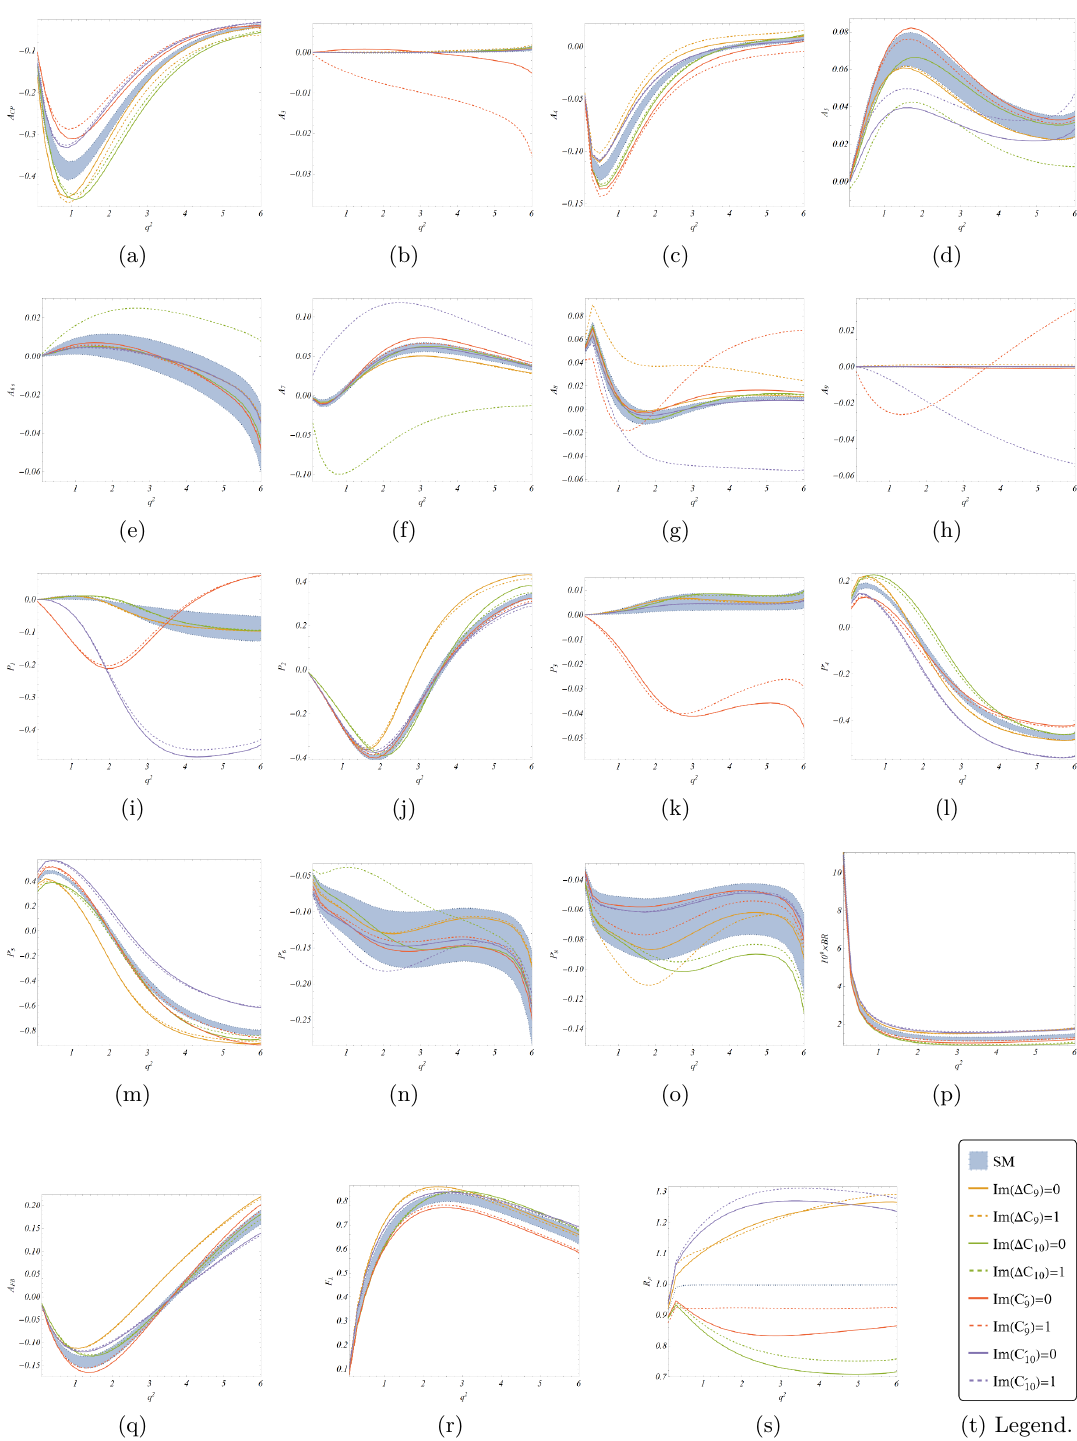
Figure 2 . The q 2 dependence of the observables in B ± → ρ ± ll decays, which are measurable at both the LHCb and Belle. The variations are shown in the SM and in the four different NP scenarios with NP Wilson coefficients ∆ C and C 0 . For the benchmarks, please see the 9 , 10 9 , 10